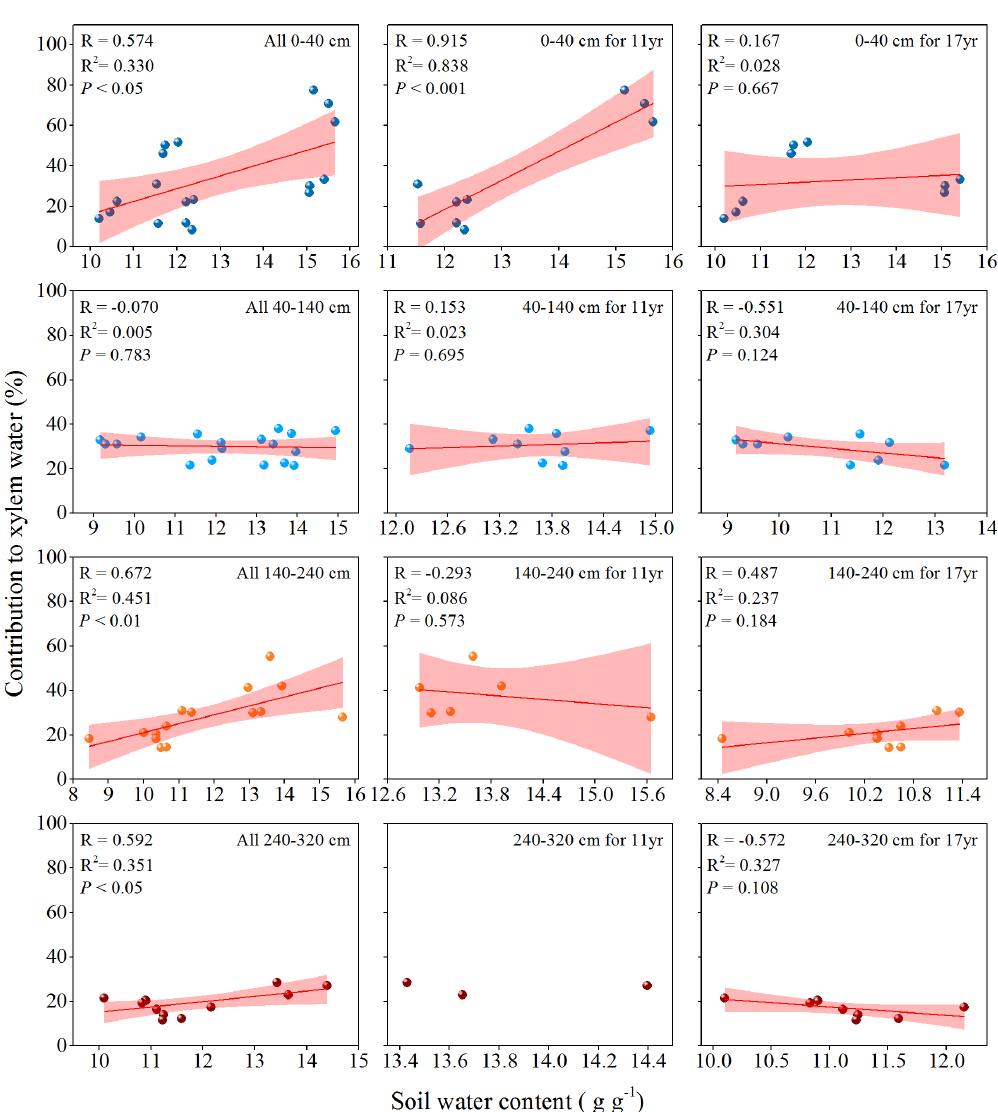
Figure 9. Relationship between the contribution of water sources and soil water content in different soil layers of 11- and 17-year-old apple